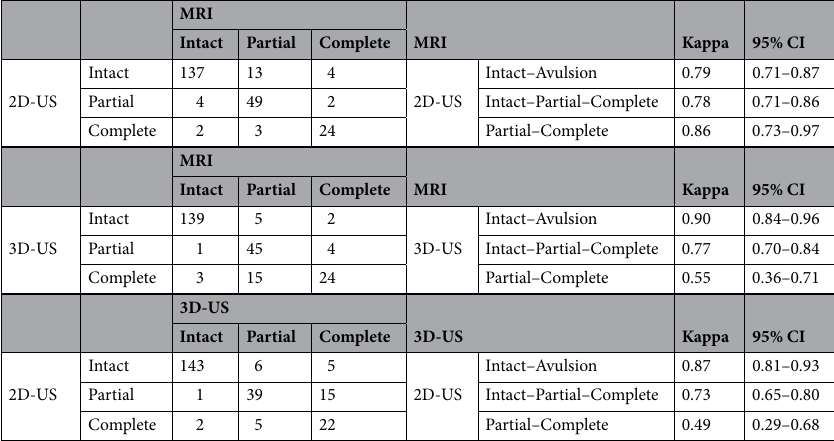
Table 2 contained the comparison of the agreement on the LAD grading assessed by 3D-US, 2D-US and MRI. Both 2D-US and 3D-US agreed well with MRI in the extent of LAD (intact-partial-complete), with the kappa of